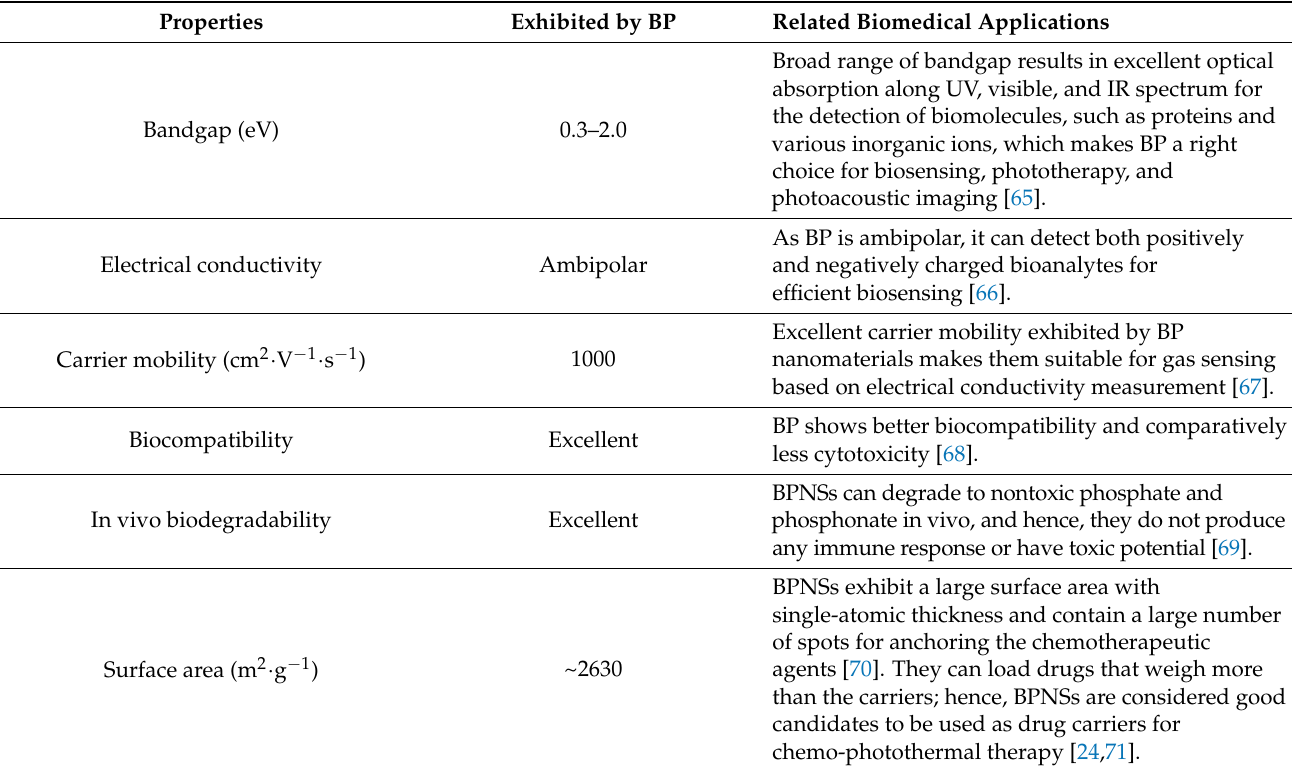
Table 1. Important characteristics of BP nanomaterials for biomedical